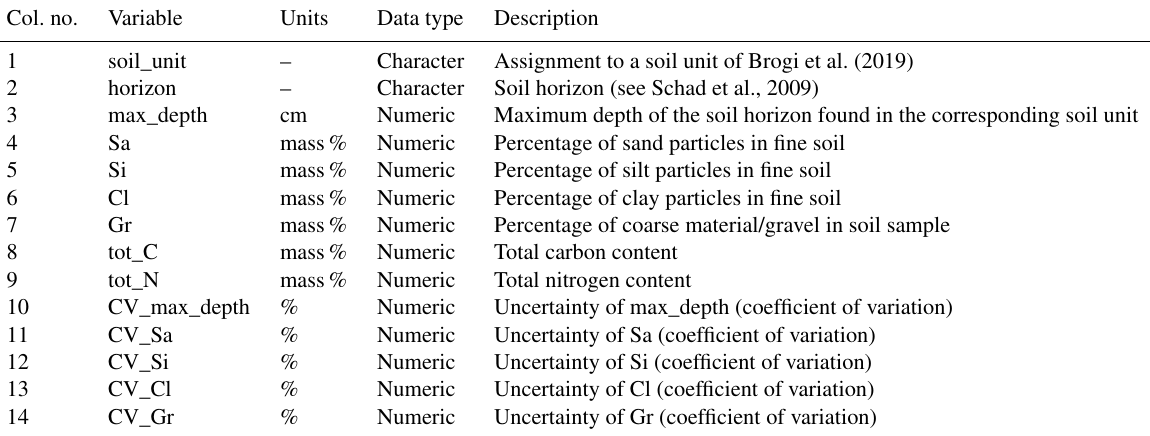
Table A6. Columns of the soil unit data file. These data exist for the site Selhausen only. For particle size classes see Table A4. Col.